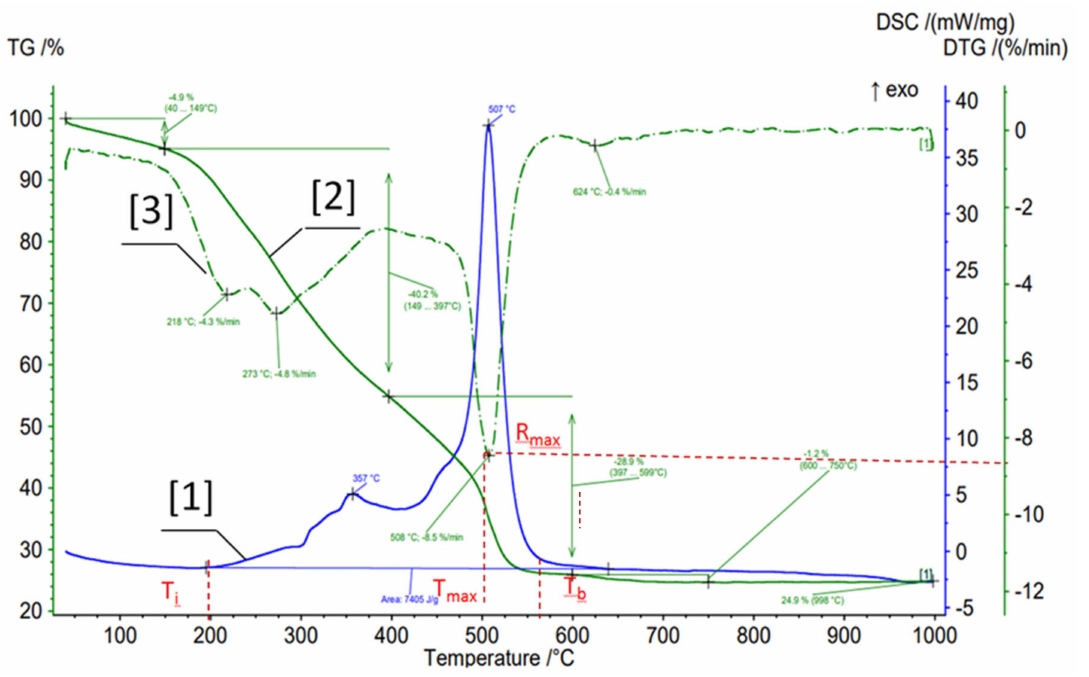
Figure 3. Results of simultaneous Thermal Analysis in the air atmosphere of sludge from primary clarifiers: 1—DSC curve, 2—mass loss curve, 3—mass loss